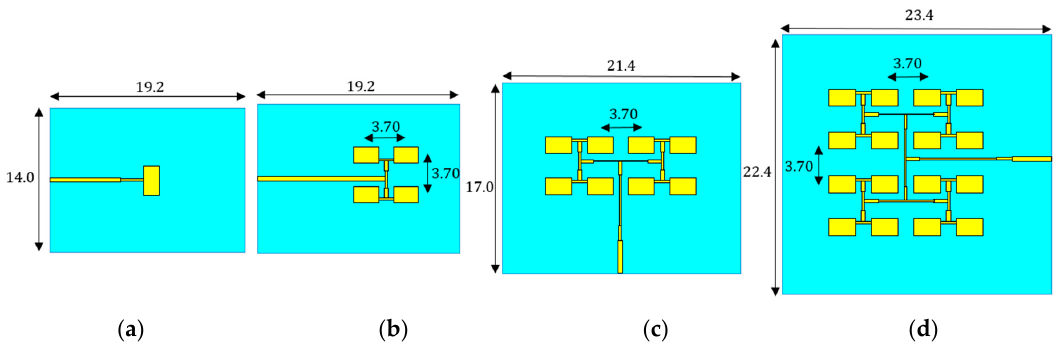
Figure 2. Antenna topologies: ( a ) single patch antenna (SPA); ( b ) 2 × 2 patch antenna array (2 × 2 PAA); ( c ) 2 × 4 patch antenna array (2 × 4 PAA); ( d ) 4 × 4 patch antenna array (4 × 4 PAA). Dimensions are in mm.